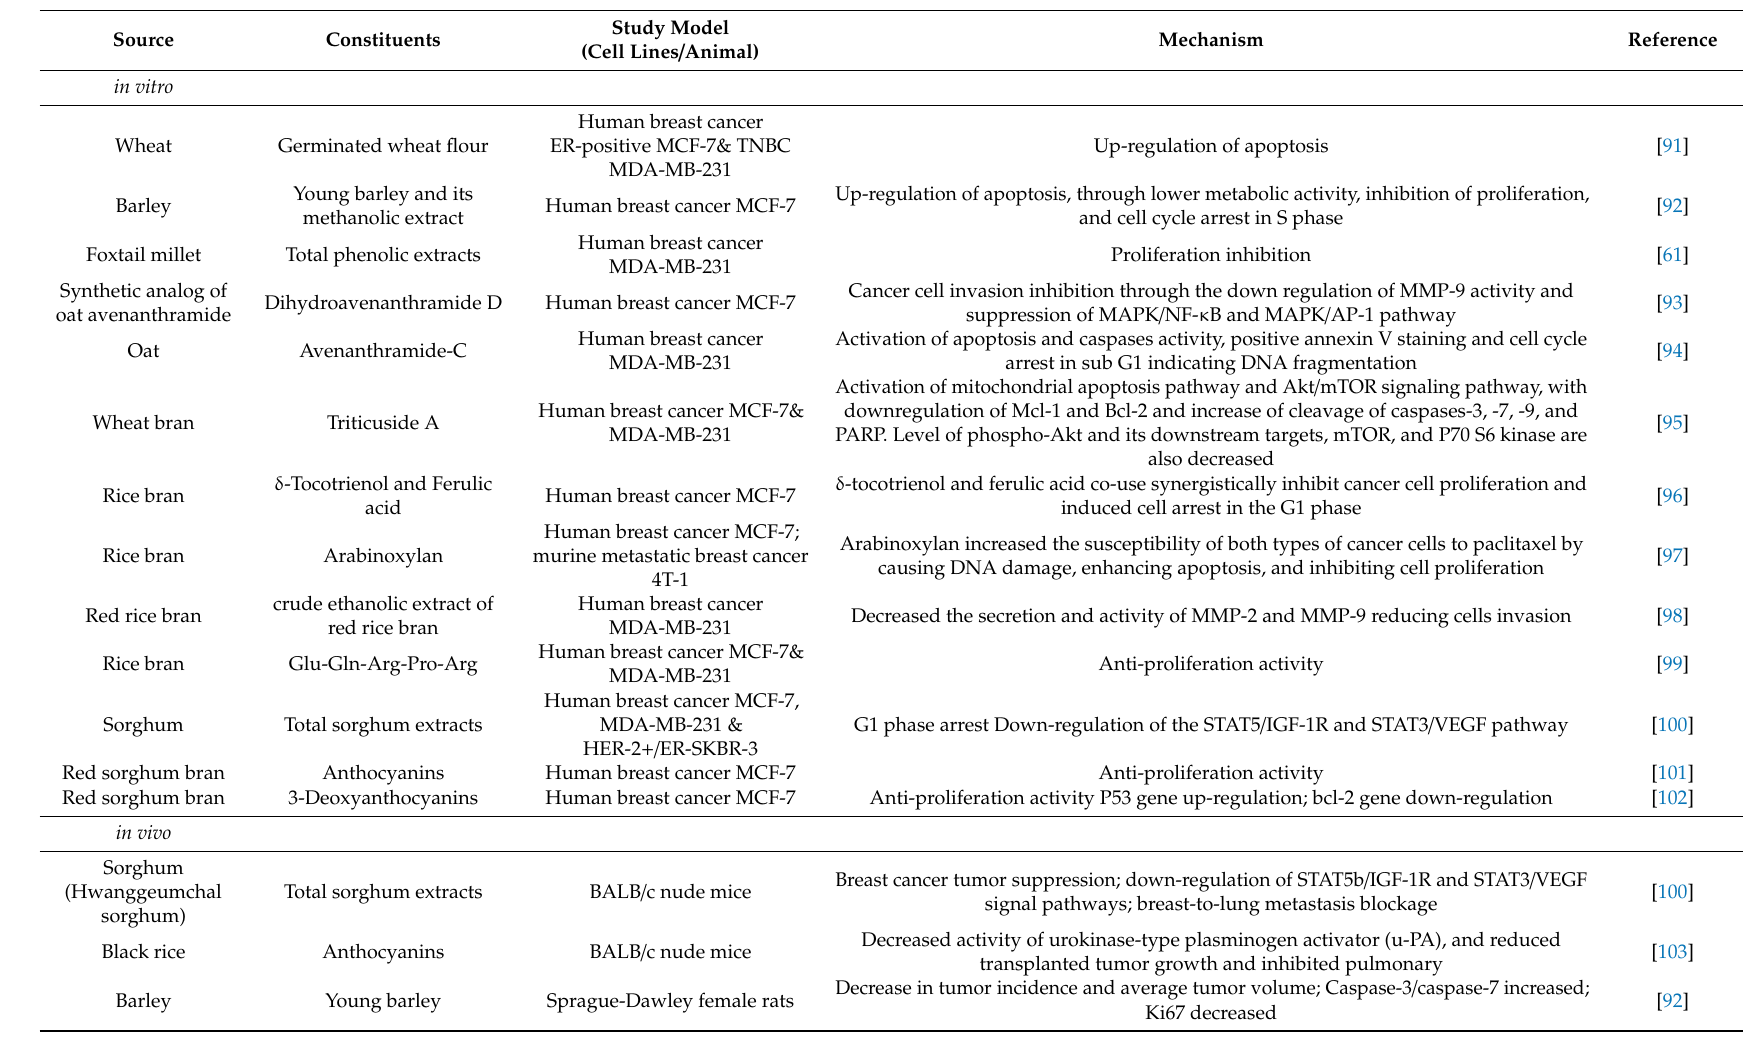
Table 4. Summary of health benefits of whole grains (and / or its components) on breast